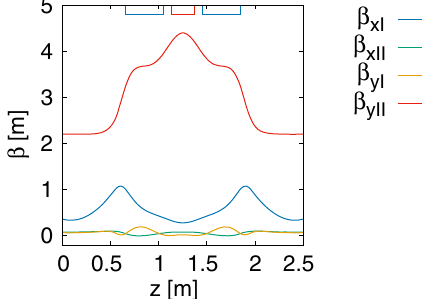
FIG. 4. Beta functions β procedure by Willeke-Ripken [17]. The magnet positioning is shown at the top, the red box corresponding to the Bd magnet and the blue box to the Bf